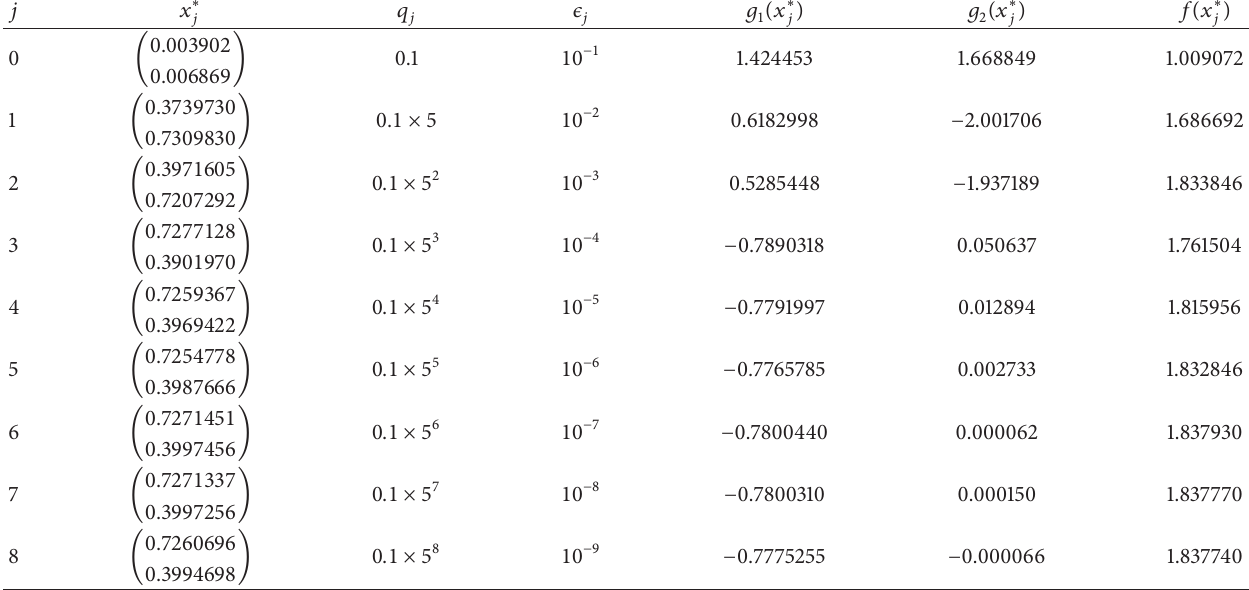
Table 2: Numerical results for Example 1 by Algorithm 10.